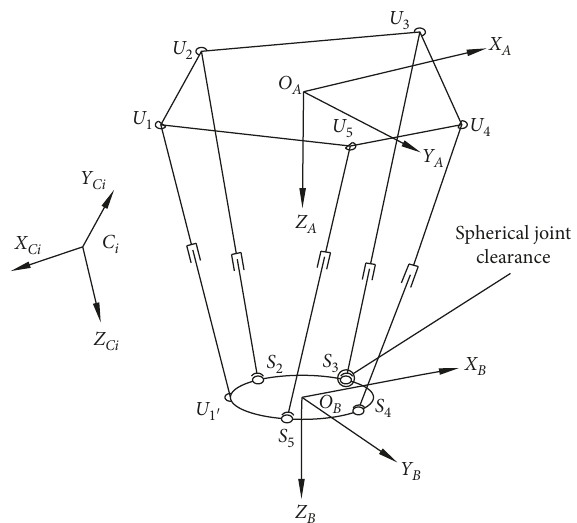
Figure 2: Coordinate systems of 4-UPS-UPU parallel